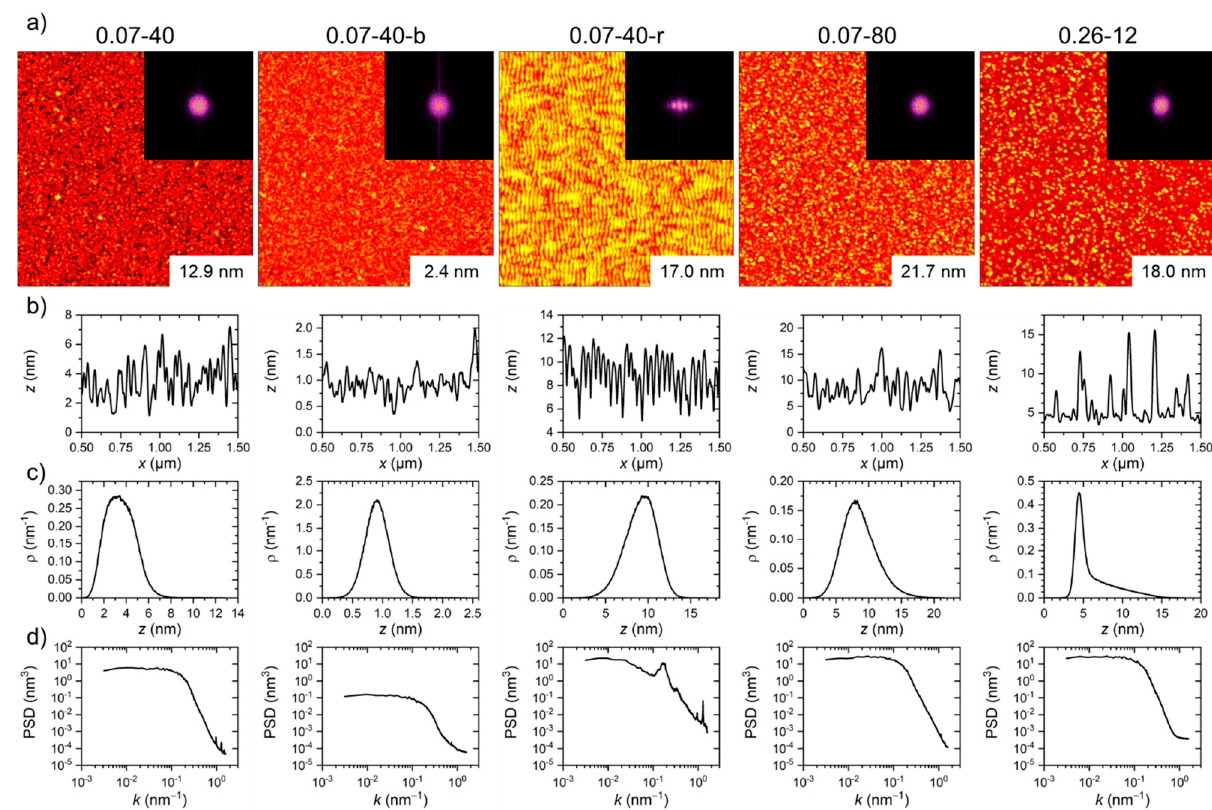
Figure 1. Representative AFM images (2 × 2 µm², ranges of the height scales as given in the images) with corresponding FFTs ( a ), horizontal height profiles taken in the center of the images ( b ), height distribution functions ( c ), and one-dimensional (horizontal) PSD functions ( d ) of the different titanium oxide samples.